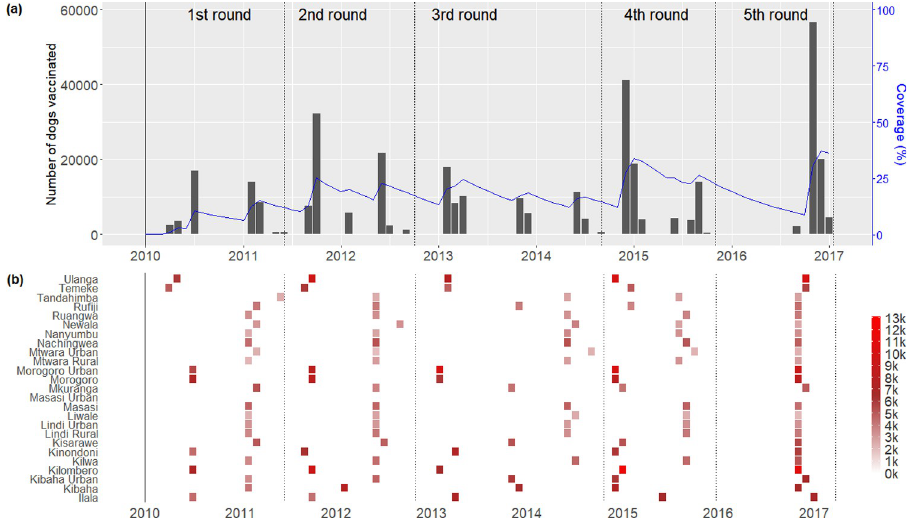
number of vaccinated dogs divided by the estimated monthly total dog population estimate (blue line). The number of dogs vaccinated in each district each month ranged from 0 to 13 thousand dogs, indicated by the “heat intensity” of the colours from white to red